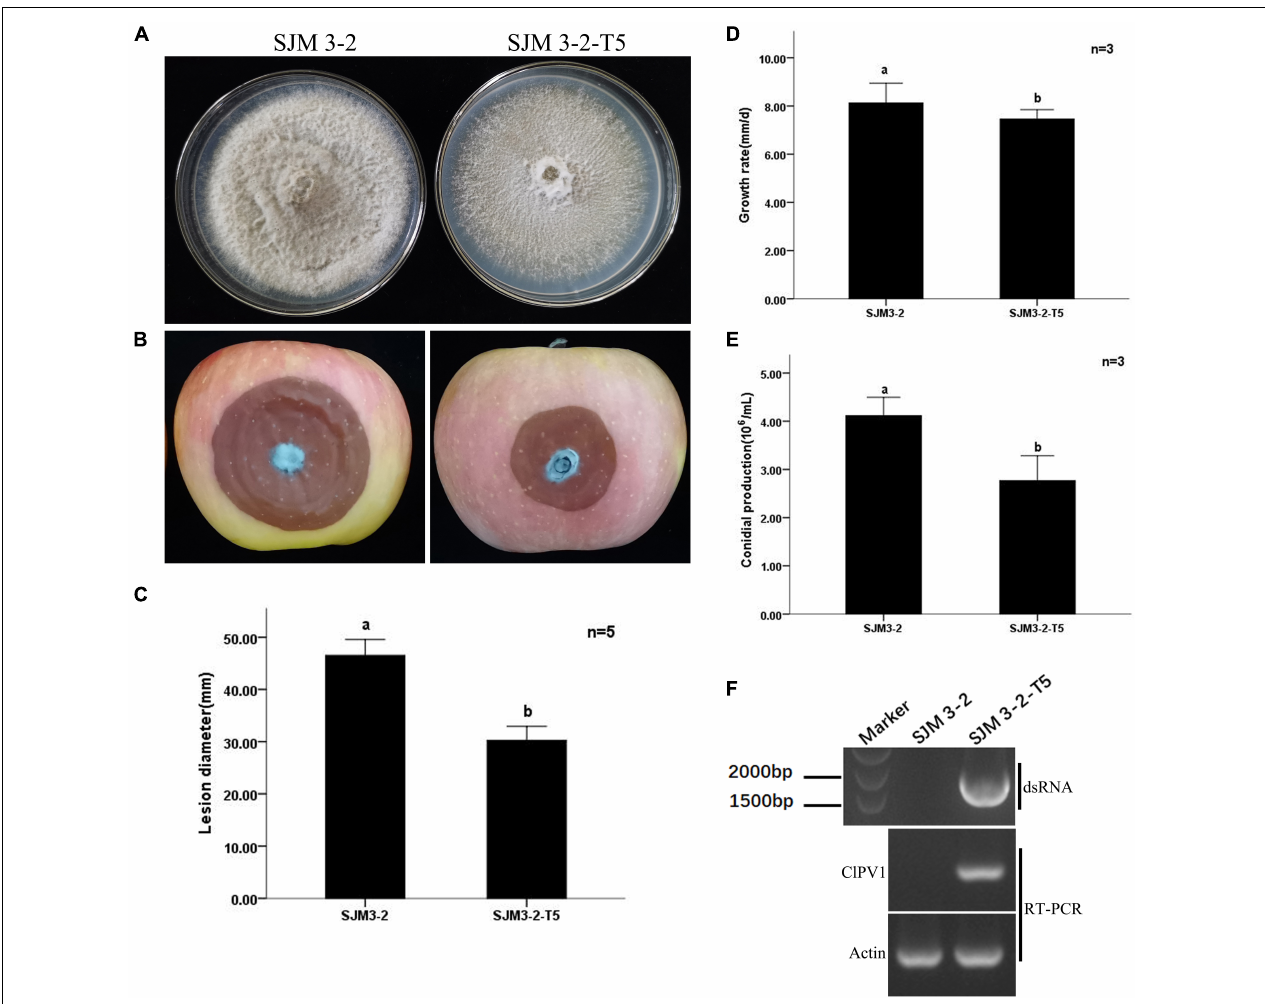
FIGURE 7 | Transfection of protoplasts of a virulent C. liriopes strain SJM3-2 with purified virus particles of ClPV1. (A) Colony morphology of strains SJM3-2 and a ClPV1 transfected derivative strain SJM 3-2-T5 on PDA at 27 ◦ C for 7 days. (B) Virulence test on apple fruits by inoculating with SJM 3-2 and SJM 3-2-T5. Symptoms were observed after 14 days of inoculation. (C) Average lesion lengths caused by SJM 3-2 and SJM 3-2-T5. (D) Comparison of the average radial mycelial growth rates between SJM 3-2 and SJM 3-2-T5 on PDA at 27 ◦ C for 7 days. (E) Comparison of the conidial production of the two strains on PD at 27 ◦ C for 5 days. (F) Virus detection in SJM 3-2 and SJM 3-2-T5 using dsRNA extraction and RT-PCR. The a, b indicate a significant difference at the P < 0.05 level of